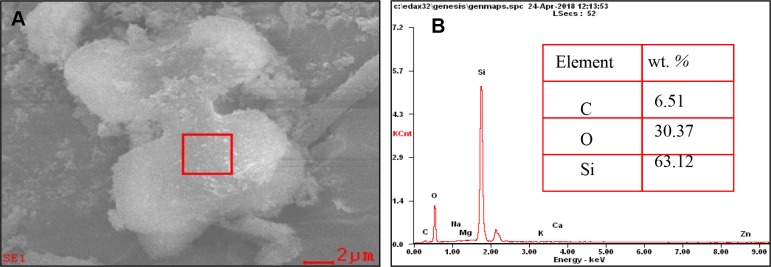
(A) Scanning electron microscope (SEM) image of rice leaf phytolith. (B) Semi-quantitative element concentration (wt. %, n = 5) measured by SEM-energy-dispersive spectroscopy (EDS) of the selected area.